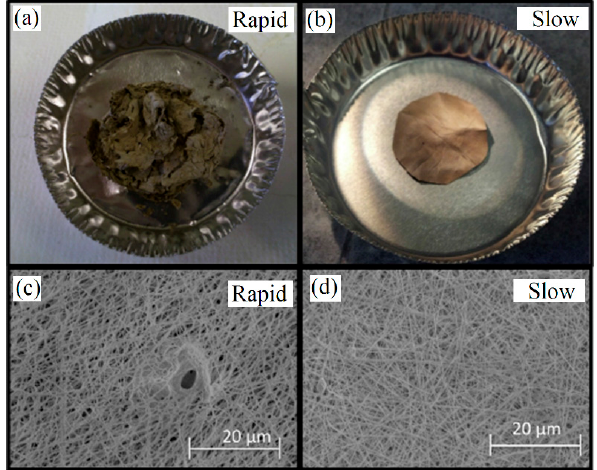
Figure 6. Image and SEM micrograph of (Pd/Cu) doped ceria in polyvinylpyrrolidone (PVP) matrix calcined at different heating rate; ( a , c ) rapid and ( b , d ) slow. Reprinted with permission from Ref. [41]. Copyright © 2014 Elsevier B.V.